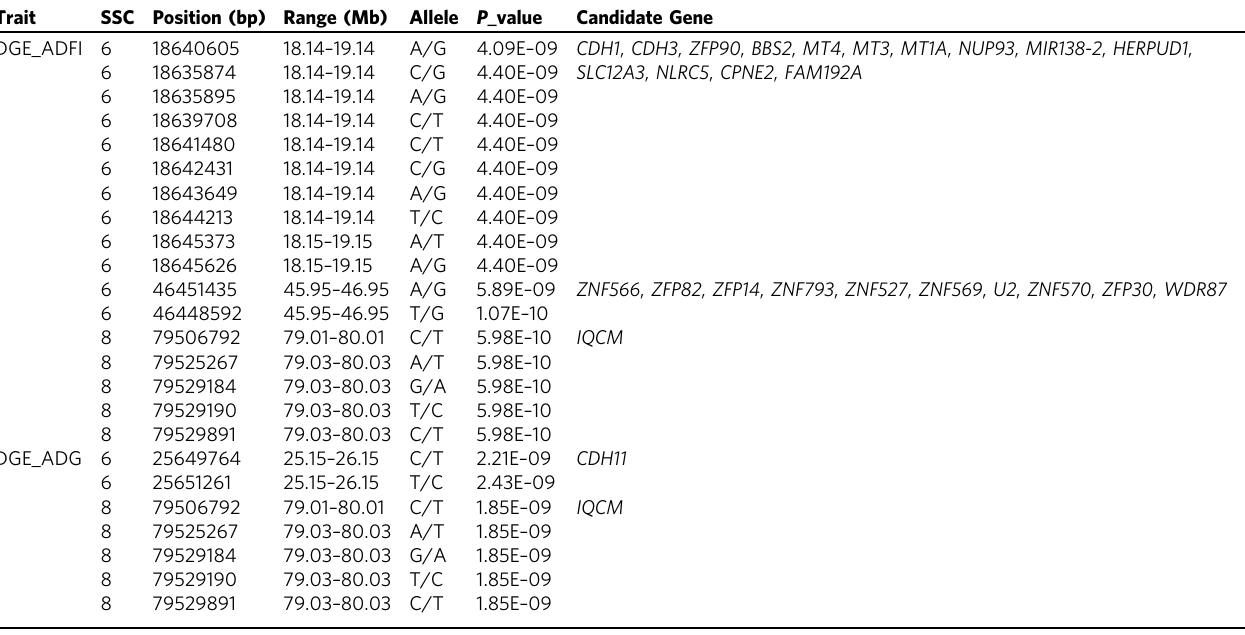
Table 3 Single-locus GWAS for direct genetic effects (DGE) in Yorkshire pigs.